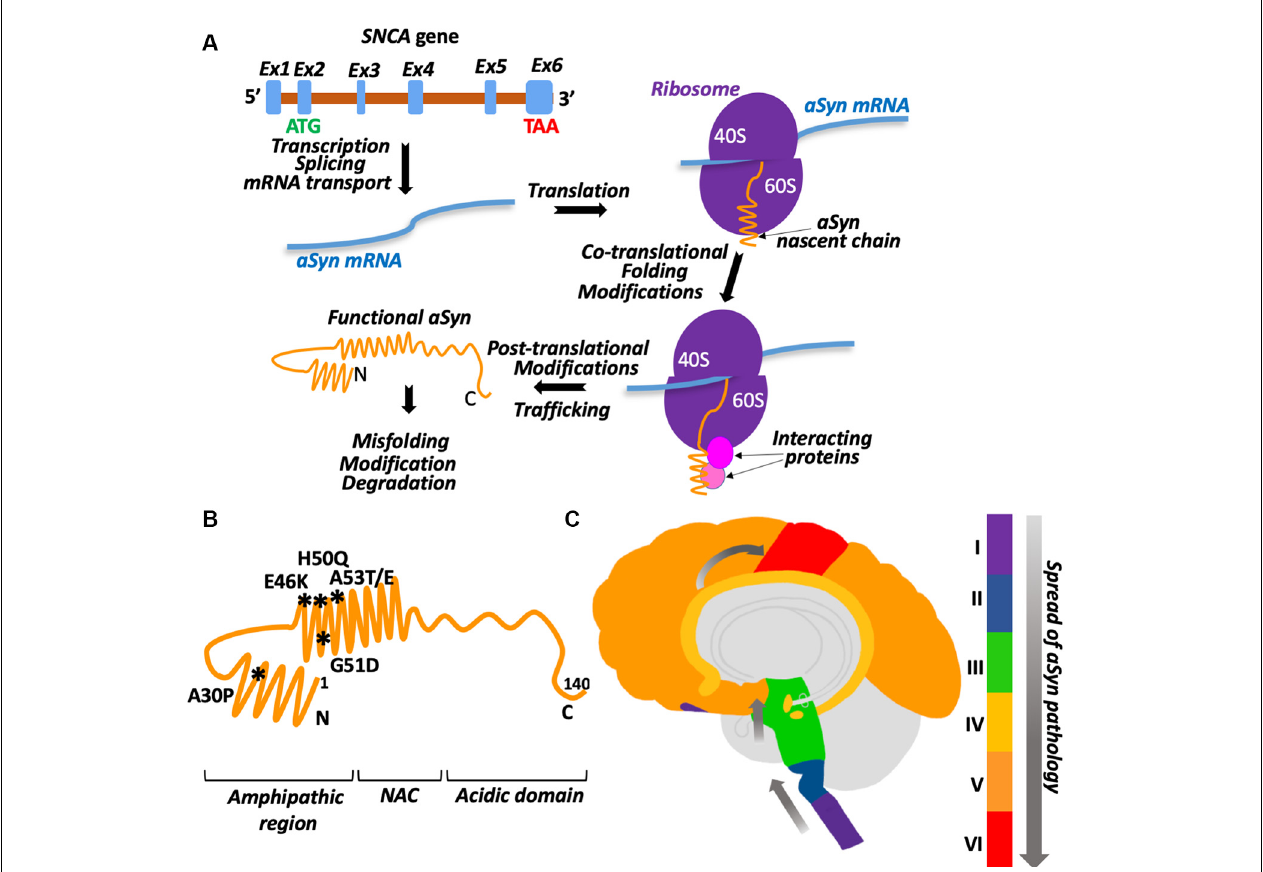
FIGURE 1 | aSyn biogenesis and pathology. (A) Graphic illustration of aSyn biogenesis. SNCA gene is encoded on chromosome 4. Its transcript is composed of six predicted exons with a start codon (ATG) localized in exon 2 and stop codon (TAA) in exon 6. After mRNA splicing and transport into the cytosol, synuclein is translated into 15 kDa protein. Proper folding and necessary modifications occur co- and post-translationally with the help of chaperones and other proteins. Ex1–Ex6 are exons, shown as blue boxes on a pre-mRNA (brown), ribosomes are shown as two purple half-spheres (40S and 60S subunits), aSyn mRNA is a blue waved line, interacting proteins are depicted as spheres. See the text for details. (B) Schematic presentation of aSyn protein structural domains with the location of clinical mutations. Amino acid residues 1–60: N-terminal amphipathic region (clinical mutations are shown and their positions are marked by asterisks, the region contains ubiquitination and SUMOylation sites). Amino acid residues 61–95: non-amyloid beta component (NAC). Amino acid residues 96–140: C-terminal acidic domain (contains phosphorylation sites). (C) Schematic presentation demonstrating the spread of aSyn pathology in the brain with Parkinson’s disease (PD). Stage I: olfactory bulb/medulla (purple), stage II: pons (blue), stage III: midbrain (including substantia nigra-green), stage IV: limbic lobe (yellow), stage V: neocortex (orange), stage VI: primary sensory/motor cortices